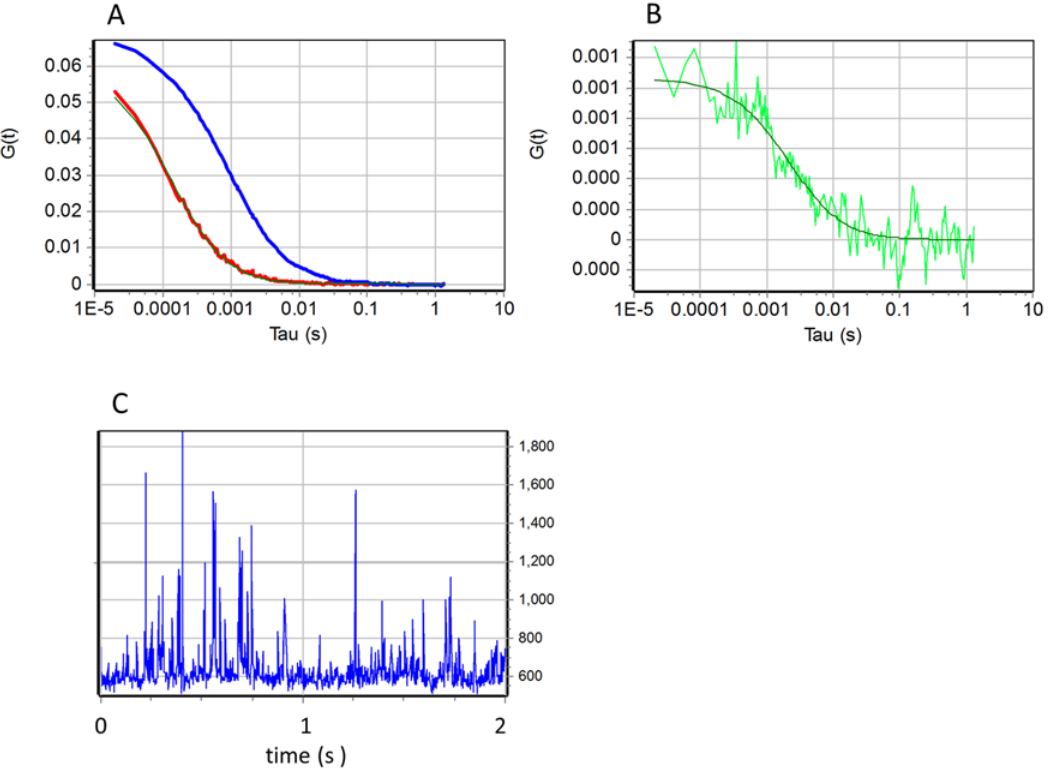
Fig 10. Solution fluctuation spectroscopy of 1 nM AuNP nanoparticles and 100nM EGFP. (A) Autocorrelation function of 1nM suspension of gold nanoparticles using a laser at 488nm and detecting the particle in confocal reflection (blue line) and of 100 nM EFGP excited at 488nm and viewed with an emission bandpass at 525/20 (red curve). When the AuNPs and the EGFP where together in the same sample the two autocorrelation curves remain almost identical. (B) Cross-correlation between the two channels (green curve) and the fit (black) using the same parameters for the fit of the autocorrelation curve of the sample with the AuNPs alone. (C) Intensity fluctuations in the reflection channel showing spikes due to the AuNPs passing in the volume of